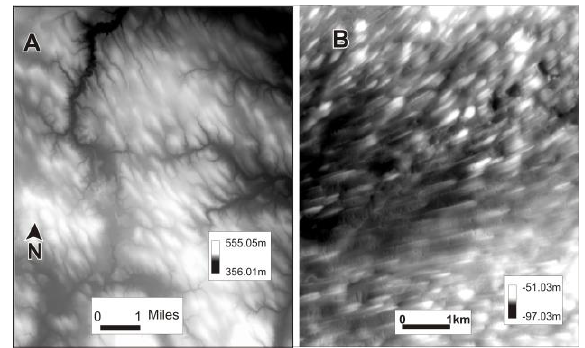
Figure 3. A. Raw DEM data for the terrestrial Test Area (B. Raw DEM for submarine Test Area.